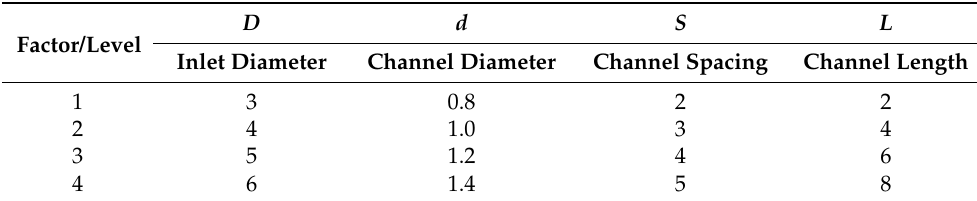
Table 2. Orthogonal parameter table.